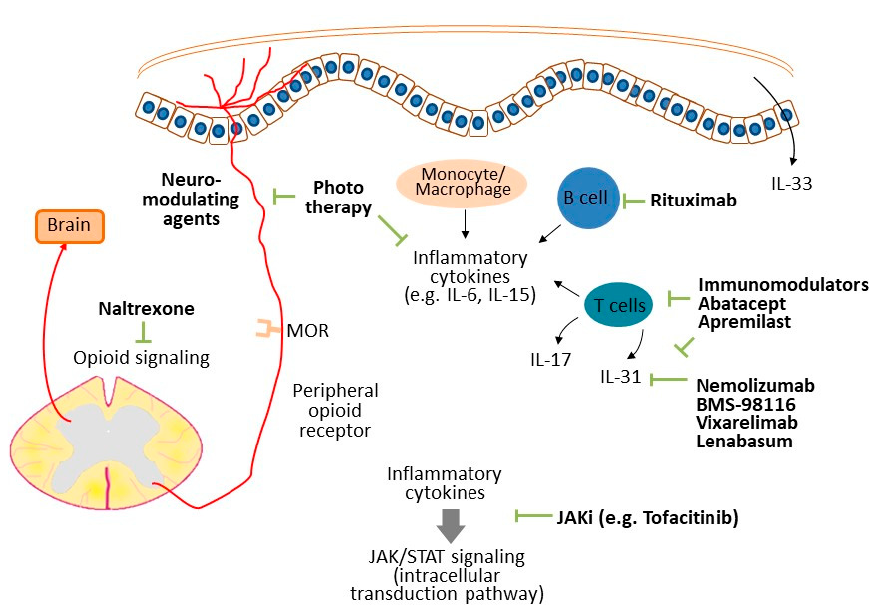
Figure 1. The possible mechanisms of ACTD-related pruritus. Inflammatory cytokines, such as IL-33 and IL-31, released from keratinocytes and immune cells transduce the itch sensation directly. Mean- while, other inflammatory cytokines might participate in pruritus transduction through activation of the JAK/STAT pathway. Small-fiber neuropathy and opioid signaling also modulate the perception of pruriception. Therapies targeting the above mediators might reduce the intensity of itch in patient with ACTDs.